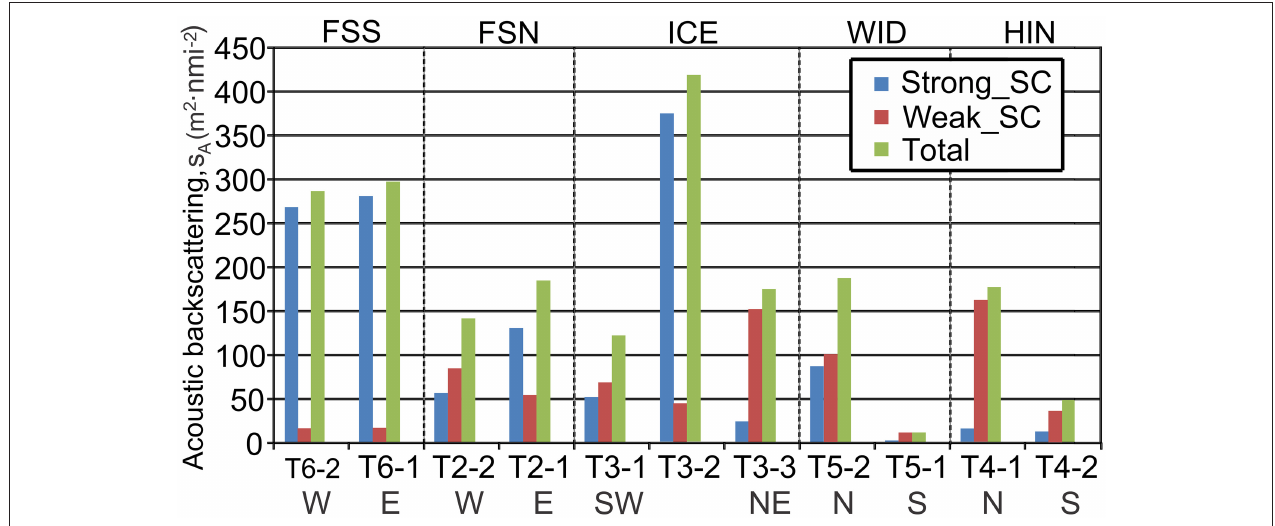
FIGURE 7 | Integrated water column acoustic backscattering s A , Nautical area scattering coefficient in units of (m 2 nmi − 2 ) for the categories Weak_SC, Strong_SC and Total s A by subsection within transects as indicated in Figure 5 . W, West; E, East; S, South; N, North; NE, North-east; SW, South-west; FSS, Fram Strait South; FSN, Fram Strait North; ICE, Along Ice Edge; WID, Wijdefjorden; HIN,